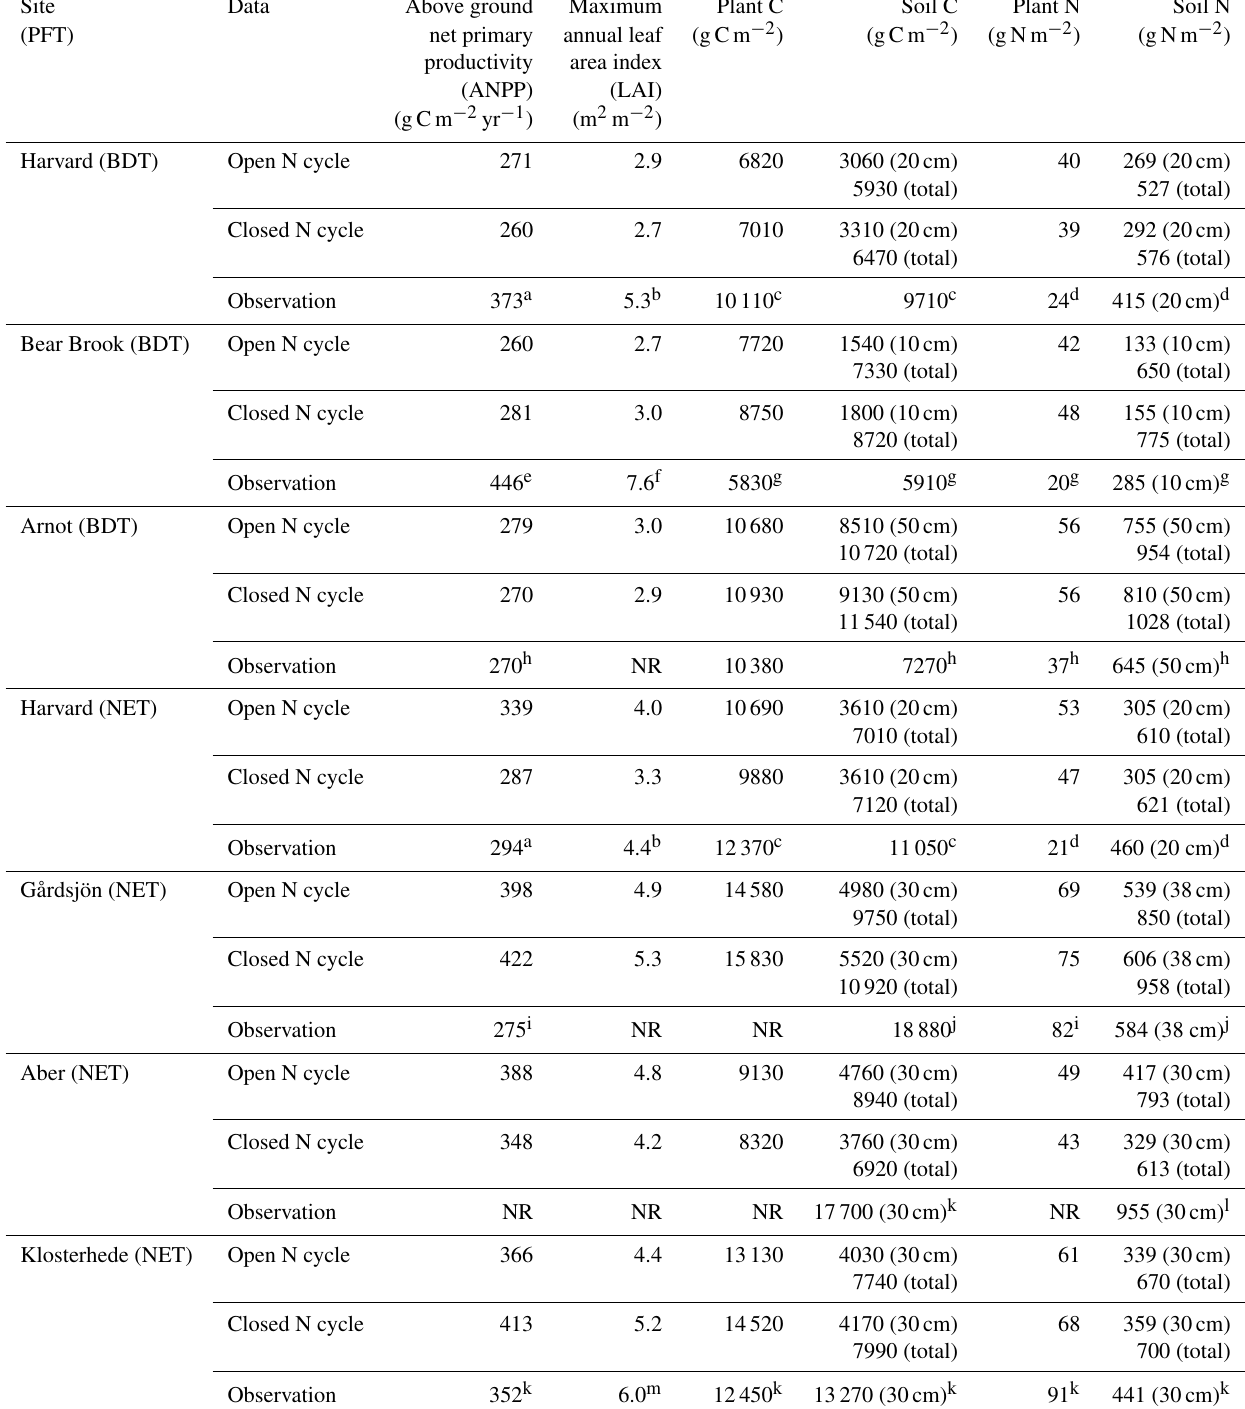
Table 3. Comparison of mean nitrogen (N) and carbon (C) stocks and annual fluxes in modeled ecosystems with an open and closed N cycle at the end of baseline historical simulations. Sites fall into one of two plant functional types (PFT) in CLM5: broadleaf deciduous temperate (BDT) or needleleaf evergreen temperate (NET) tree. Model values are the mean of the last 20 years of the historical simulation and include total plant (above and belowground plant pools) and soil (excluding coarse woody debris and to the depth of field measurements) stocks. The total depth of the soil column in CLM5 is approximately 7.5m at our simulated sites. ANPP and C stocks reported in the literature as organic matter or biomass were converted to units of C by assuming that 50% of the organic matter is